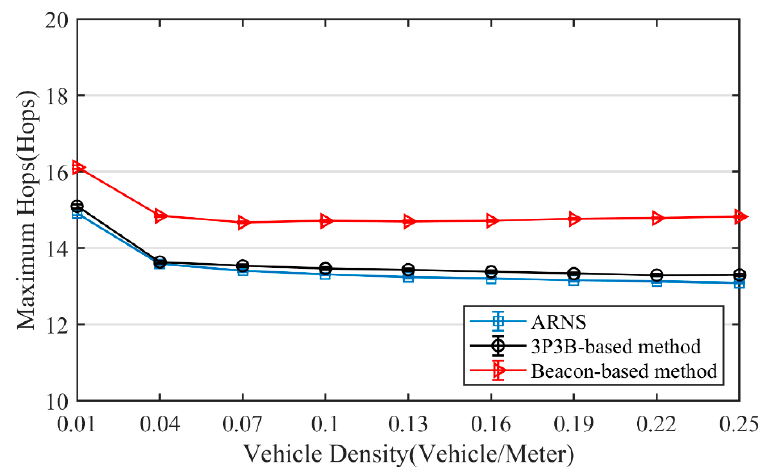
Figure 5. Maximum hops.